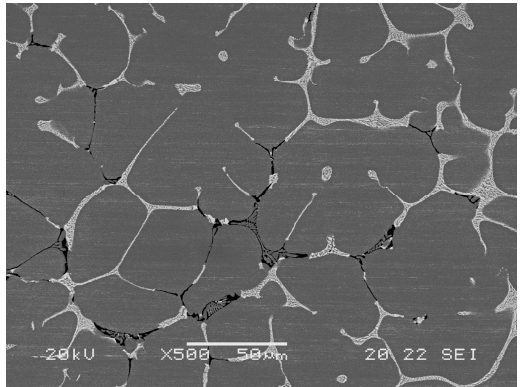
Figure 3. Characteristic microstructure of the material after continuous casting, obtained by scanning electron microscopy. Gray phase: solid solution (Al); White phase: Cu 2 Al; Black phase: Mg 2 Si.